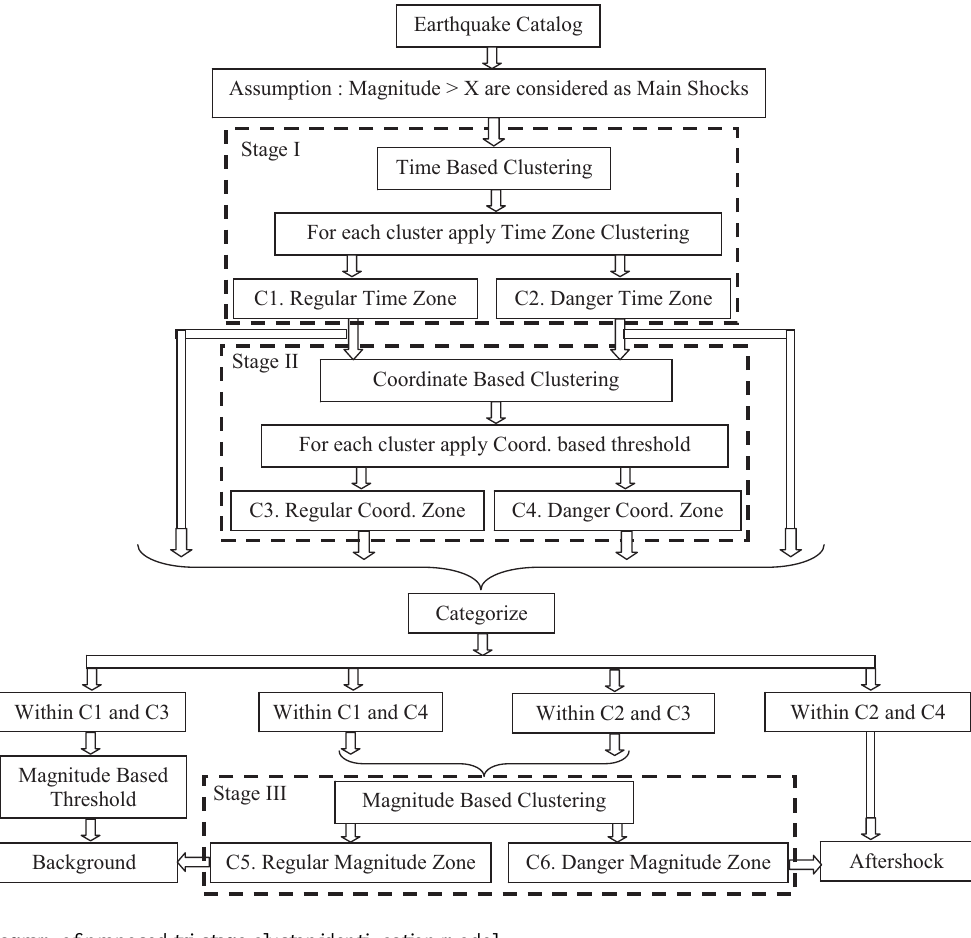
where M =5 is the number of mainshocks of catalog.